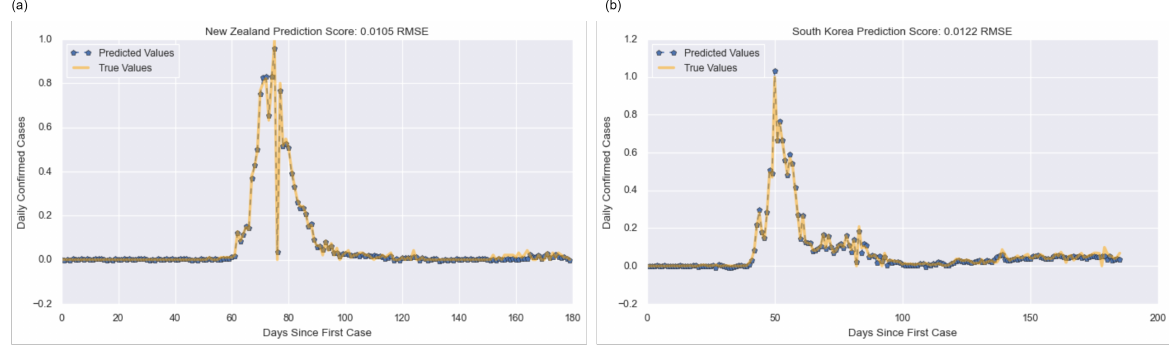
Figure 16. Validation results of LSTM models for daily COVID-19 cases predictions for countries (New Zealand (a) and South Korea (b)) of Successful